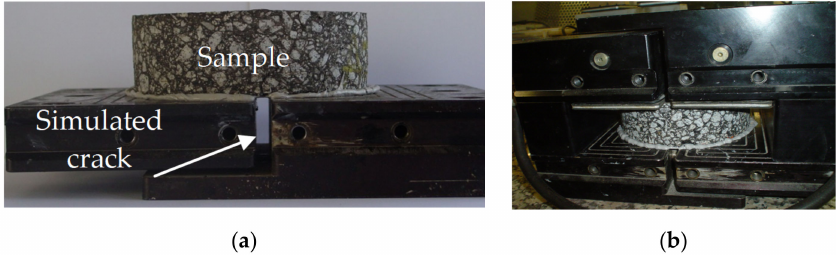
Figure 5. Samples, simulated crack, and the assembled set. ( a ) Sample and simulated crack RCD device. ( b ) Sample into the CAM.